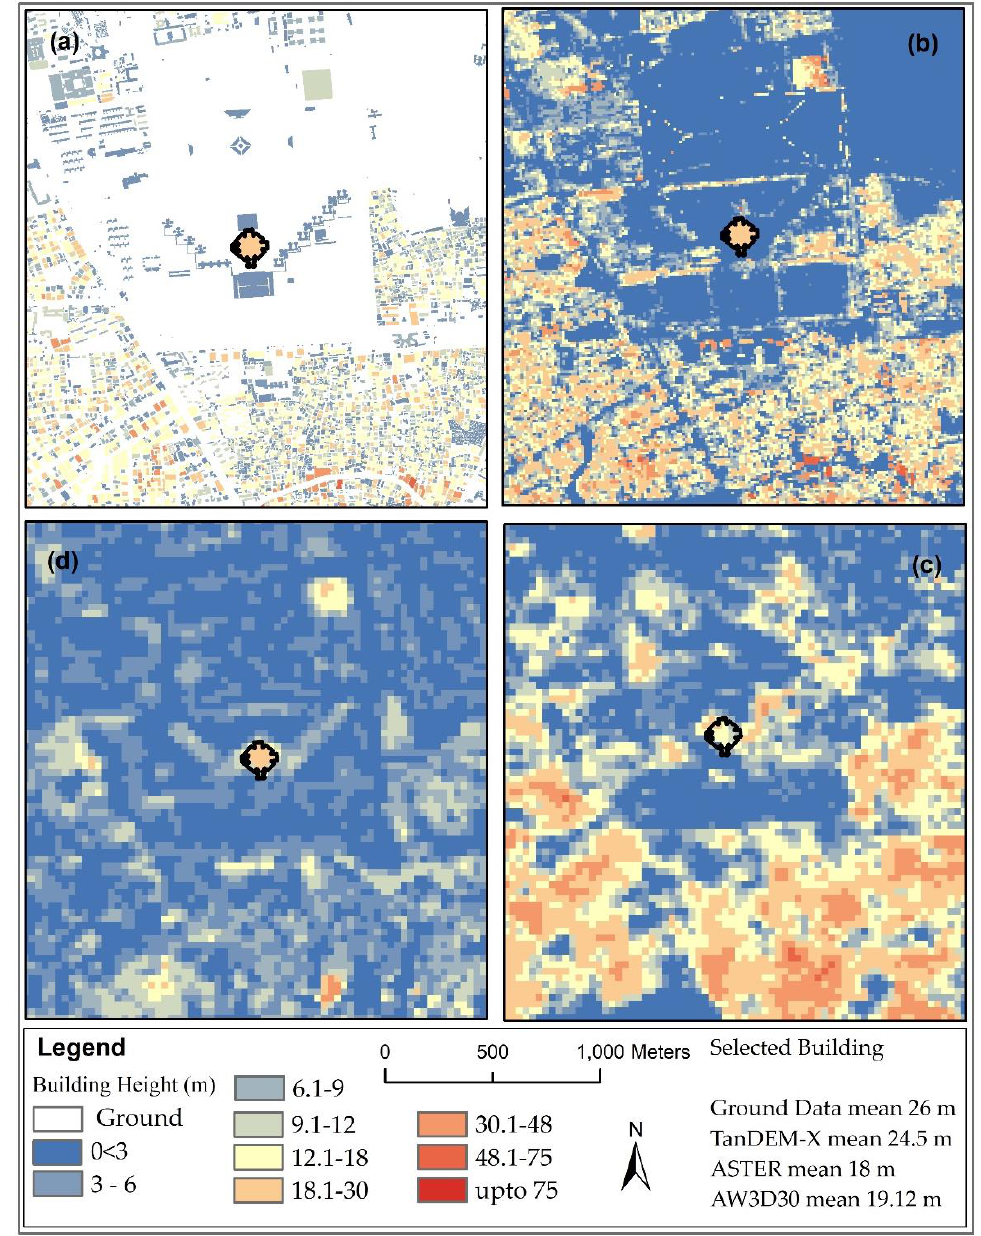
Figure 5. ( a ) Ground / referenced height, ( b ) TanDEM-X height Data, ( c ) ASTER height, and ( d ) AW3D30.